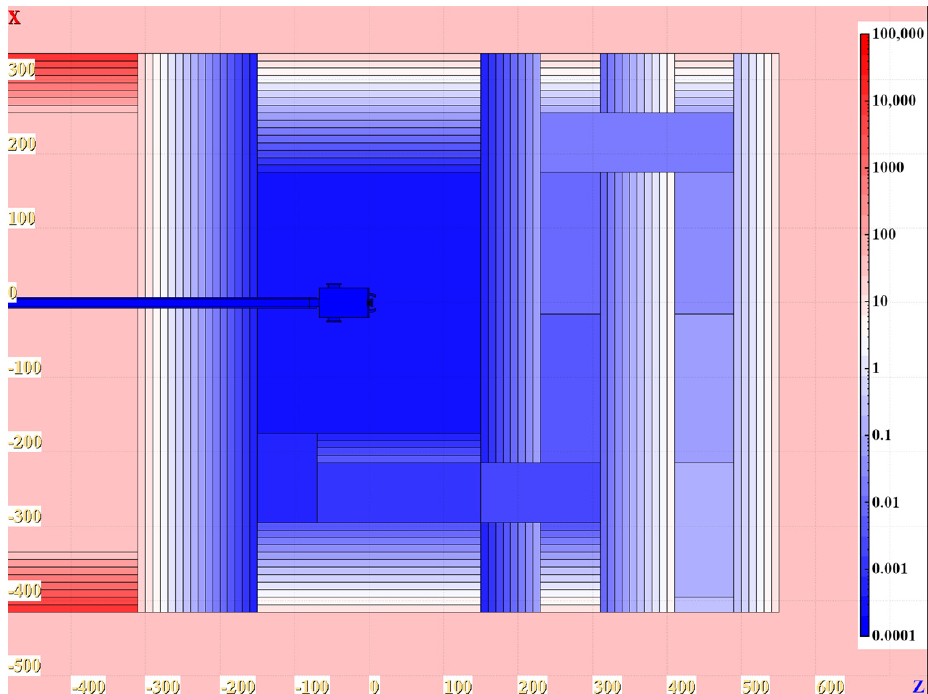
Figure 5. Region importance biasing (10 − 4 ~10 5 ). Distances are given in cm. The effects of the different variance reduction methods were compared, as shown in Figure 6. Both the methods could significantly improve the statistics of events after pene- trating the shielding body. Method 2 provided a better result according to the comparison. The CPU chip used in the calculation was the Intel(R) Xeon(R) Gold 6240 CPU @ 2.60 GHz. The average time per primary in Method 1 (6.4 × 10 − 5 s/primary) and Method 2 (7.8 × 10 − 5 s/primary) are, respectively, 6.3 and 7.7 times full-simulation (1.0 × 10 − 5 s/primary). If the geometry buildup time is considered, the total time con- sumption for Method 2 is much longer. Thus, when encountering shielding issues during management of large-scale nuclear facilities based on FLUKA, weighing the accuracy of simulation results and the progress of the project at the same time, the following simulation strategy should be